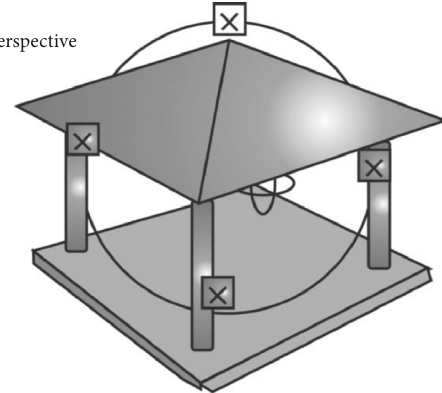
Figure 7: Extended standard primitive